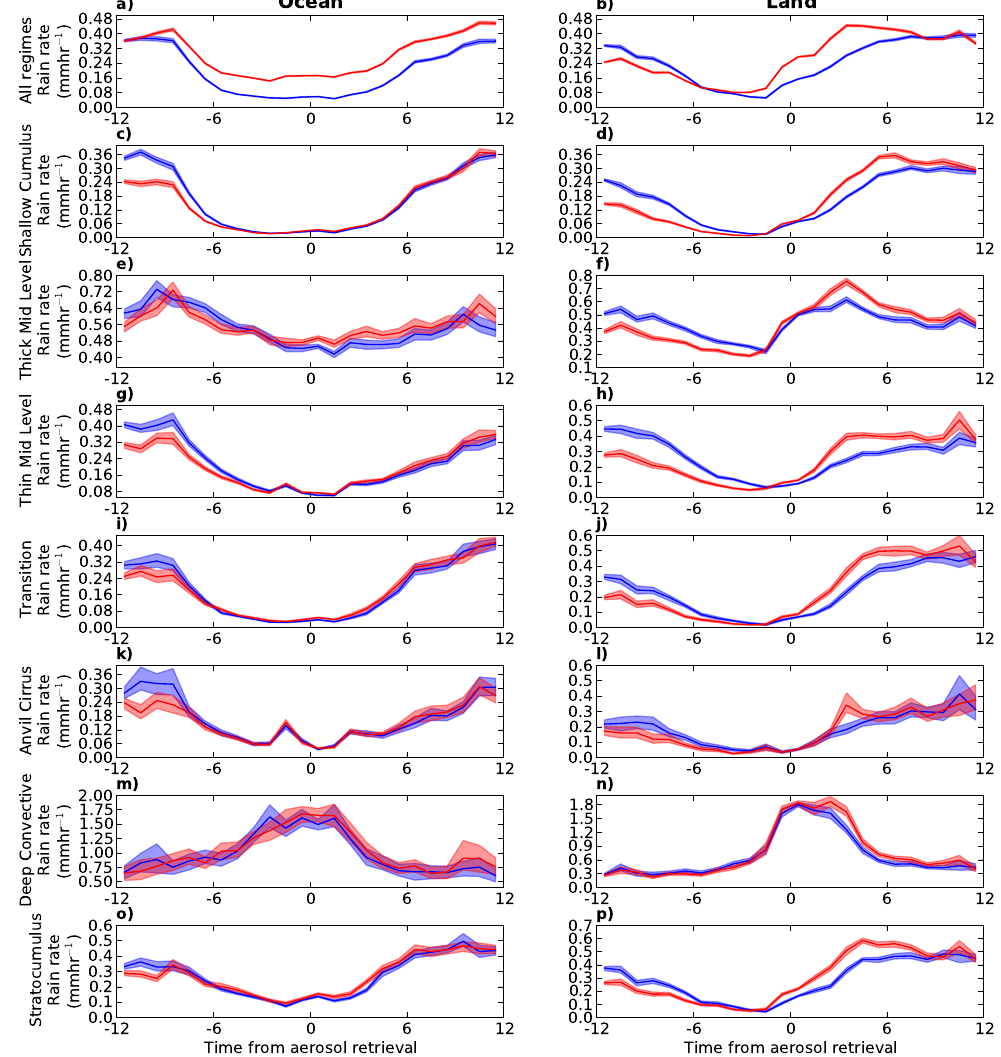
Figure 8. As Fig. 2, but using ISCCP CTT to remove all clouds with a mean CTT of more than 273K, keeping only mixed- and ice-phase